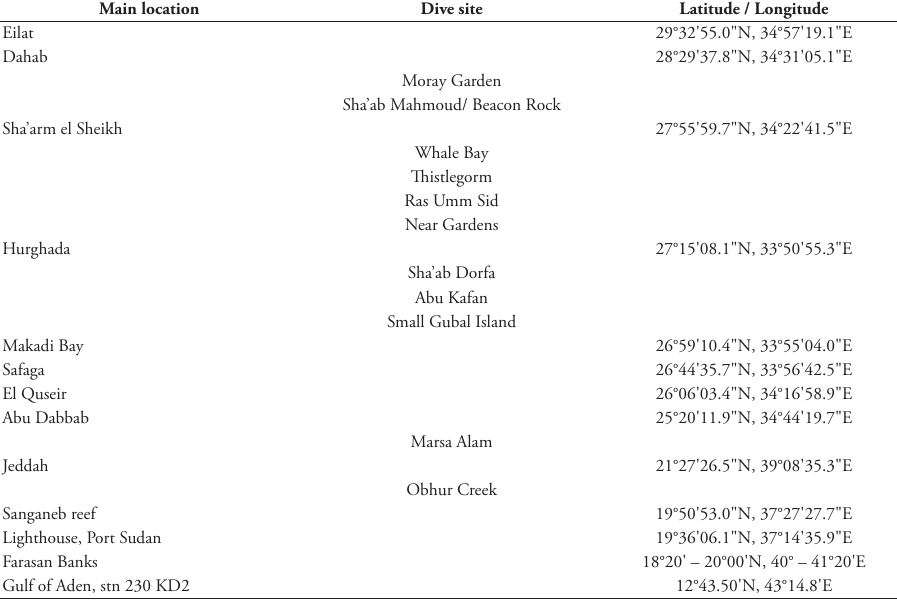
Table 1. Georeferenced collection and photographic localities, from north to south. Main